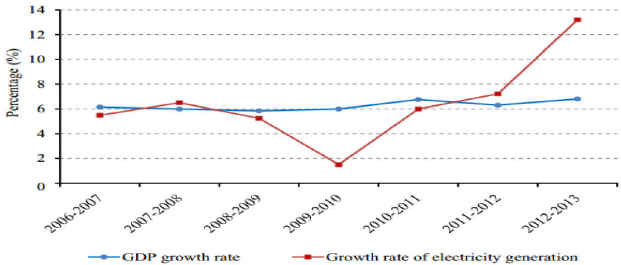
A. Demand of Electricity vs Climate of Bangladesh Figure 1: GDP Growth Rate with Electricity Access Bangladesh is located between 20° to 26° North and 88° to 92° east. It is bordered on the west, north and east by India, on the south-east by Myanmar, and on the south by the Bay of Bengal. The geographical location of